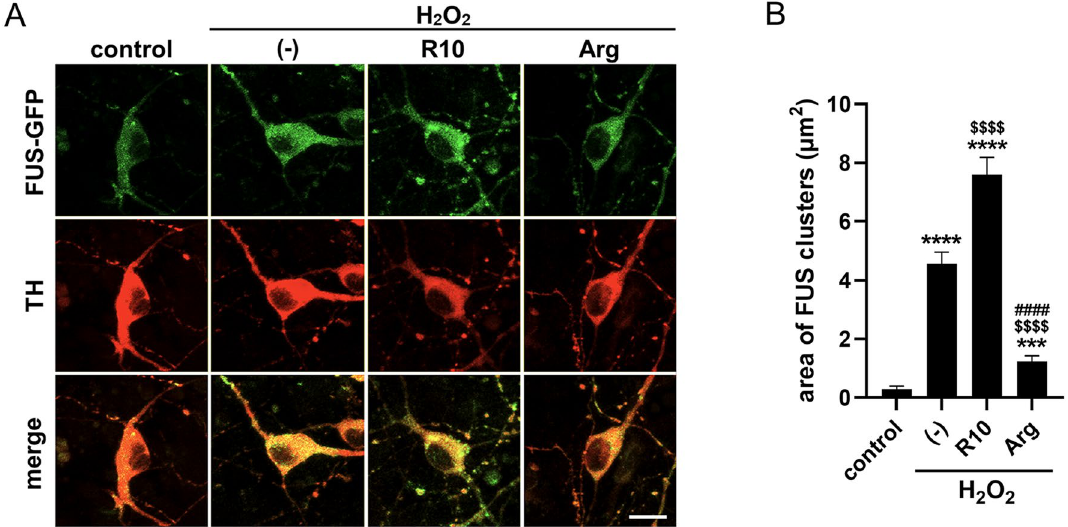
Figure 3. Arg and poly-arg additives worked similarly for regulating FUS cluster formation in cultured dopaminergic neurons. ( A ) Effect of Arg and poly-Arg additives to FUS cluster formation in the cells detected by a confocal laser scanning microscopy. Cells were transfected with FUS-GFP and exposed to H 2 O 2 with no additive ( −), R10, or Arg. FUS-GFP (green) and anti-tyrosine hydroxylase (TH) antibody (neuron cell marker, red) were respectively detected. Scale bar denotes 10 µm. ( B ) Quantification of the area of FUS clusters in TH + neurons. Error bars represent the standard errors ( N = 20). *** and **** indicate significant differences ( p < 0.001 and p < 0.0001 for control) in one-way analysis of variance (ANOVA) with post-hoc Tukey’s multiple comparison test, respectively. $$$$ and #### indicate significant differences ( p < 0.0001 for no additive ( −) and p < 0.0001 for R10) in one-way ANOVA with post-hoc Tukey’s multiple comparison test,